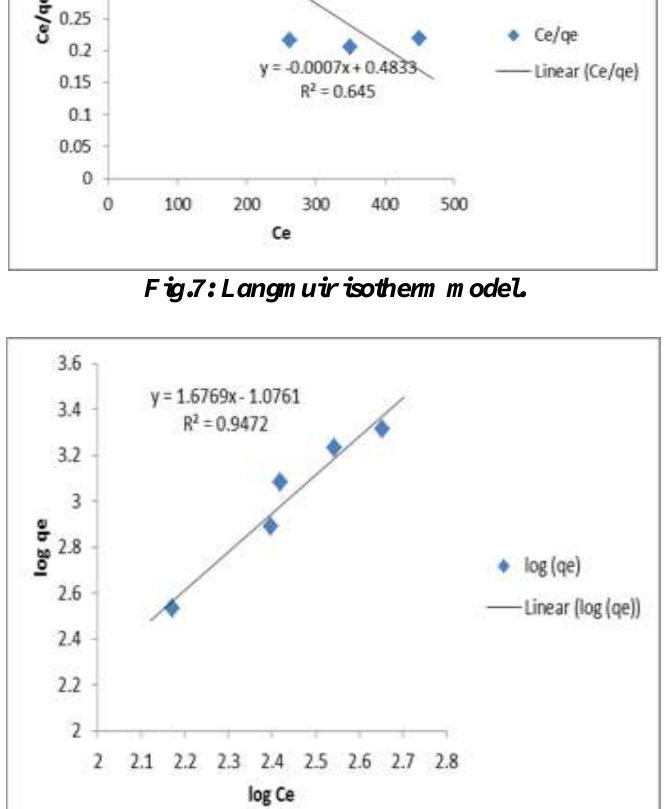
Fig.8: Freundlich isotherm